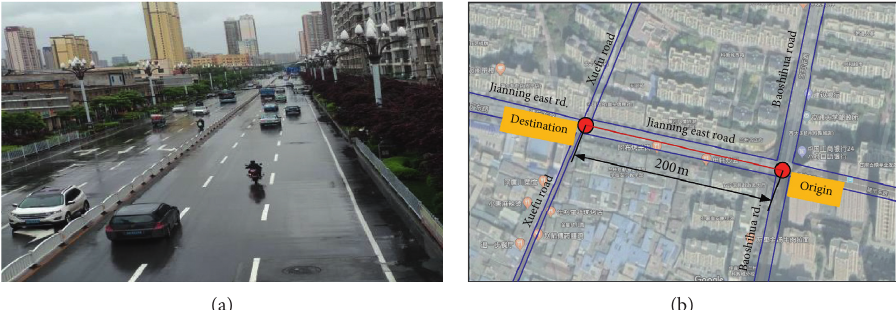
Figure 2: Actual road conditions and the length of road section chosen for the survey. (a) Actual road conditions. (b) Length of road